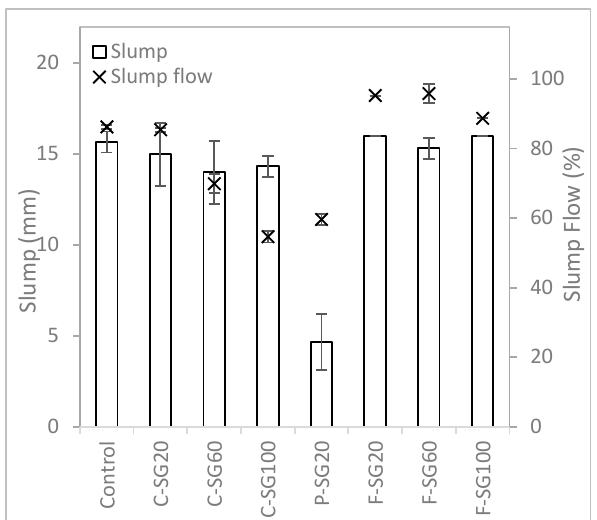
Figure 5. Slump and slump flow results of mixtures prepared with the specific gravity method. Table 2. Percentage of absorption of different raw materials. River Sand Perlite Cenospheres Foam Beads Absorption